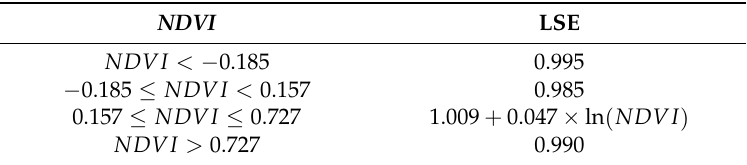
Table 2. Algorithm based on the NDVI